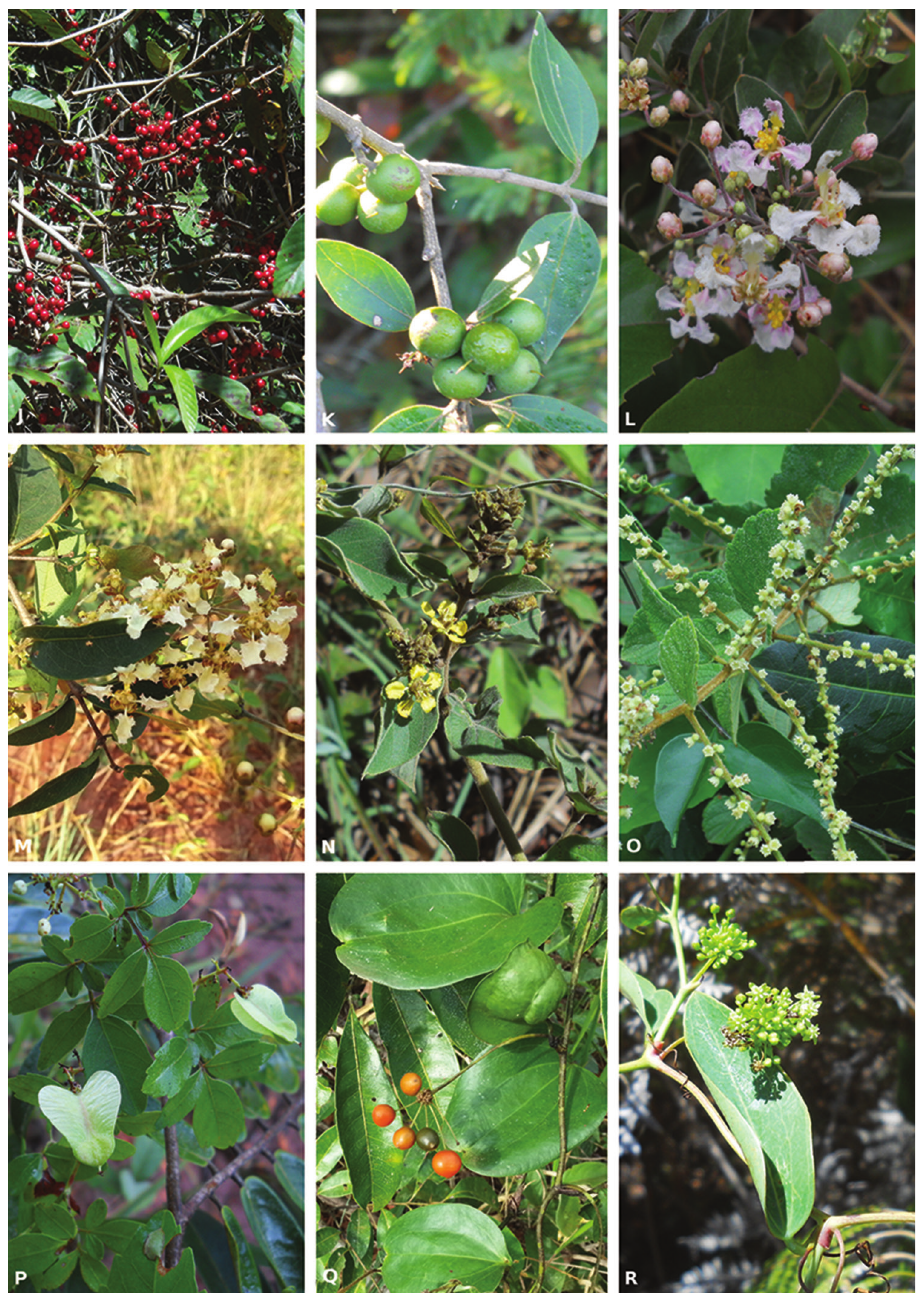
Figure 3. Dilleniaceae (J. Doliocarpus dentatus ). Loganiaceae ( K Strychnos bicolor ). Malpighiaceae ( L Ban- isteriopsis muricata M B. stellaris N Mascagnia cordifolia ). Rhamnaceae ( O Gouania latifolia ). Sapindaceae ( P Serjania confertiflora ). Smilacaceae ( Q Smilax fluminensis ; R. Smilax elastica